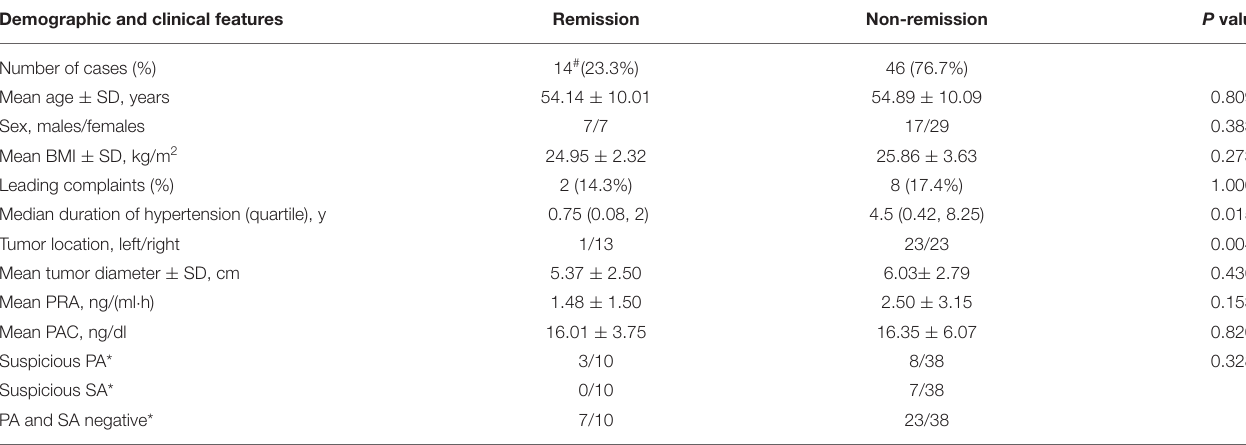
TABLE 2 | Characteristics of hypertension in 1 year after surgery.